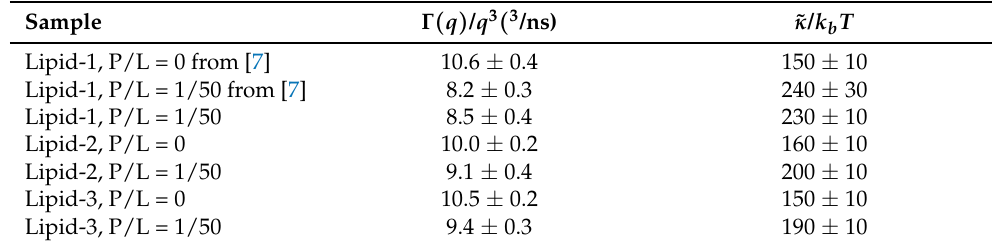
Figure 3. Relaxation rates divided by q 3 as a function of q for Lipid-1 ( A ), Lipid-2 ( B ) and Lipid-3 ( C ). The symbols for the samples with P/L = 0 are (cid:4) , while those for P/L = 1/50 are • . The solid lines are the averages reported in Table 3 and have the same color as the symbols. The dashed lines in ( A ) are the average values for P/L = 0 (black) and P/L = 1/50 (blue) determined in the previous study of gp41rk associated with Lipid-1 [7]. Table 3. Relaxation rates, Γ ( q ) / q 3 , and effective bending moduli, ˜ κ , derived from the NSE